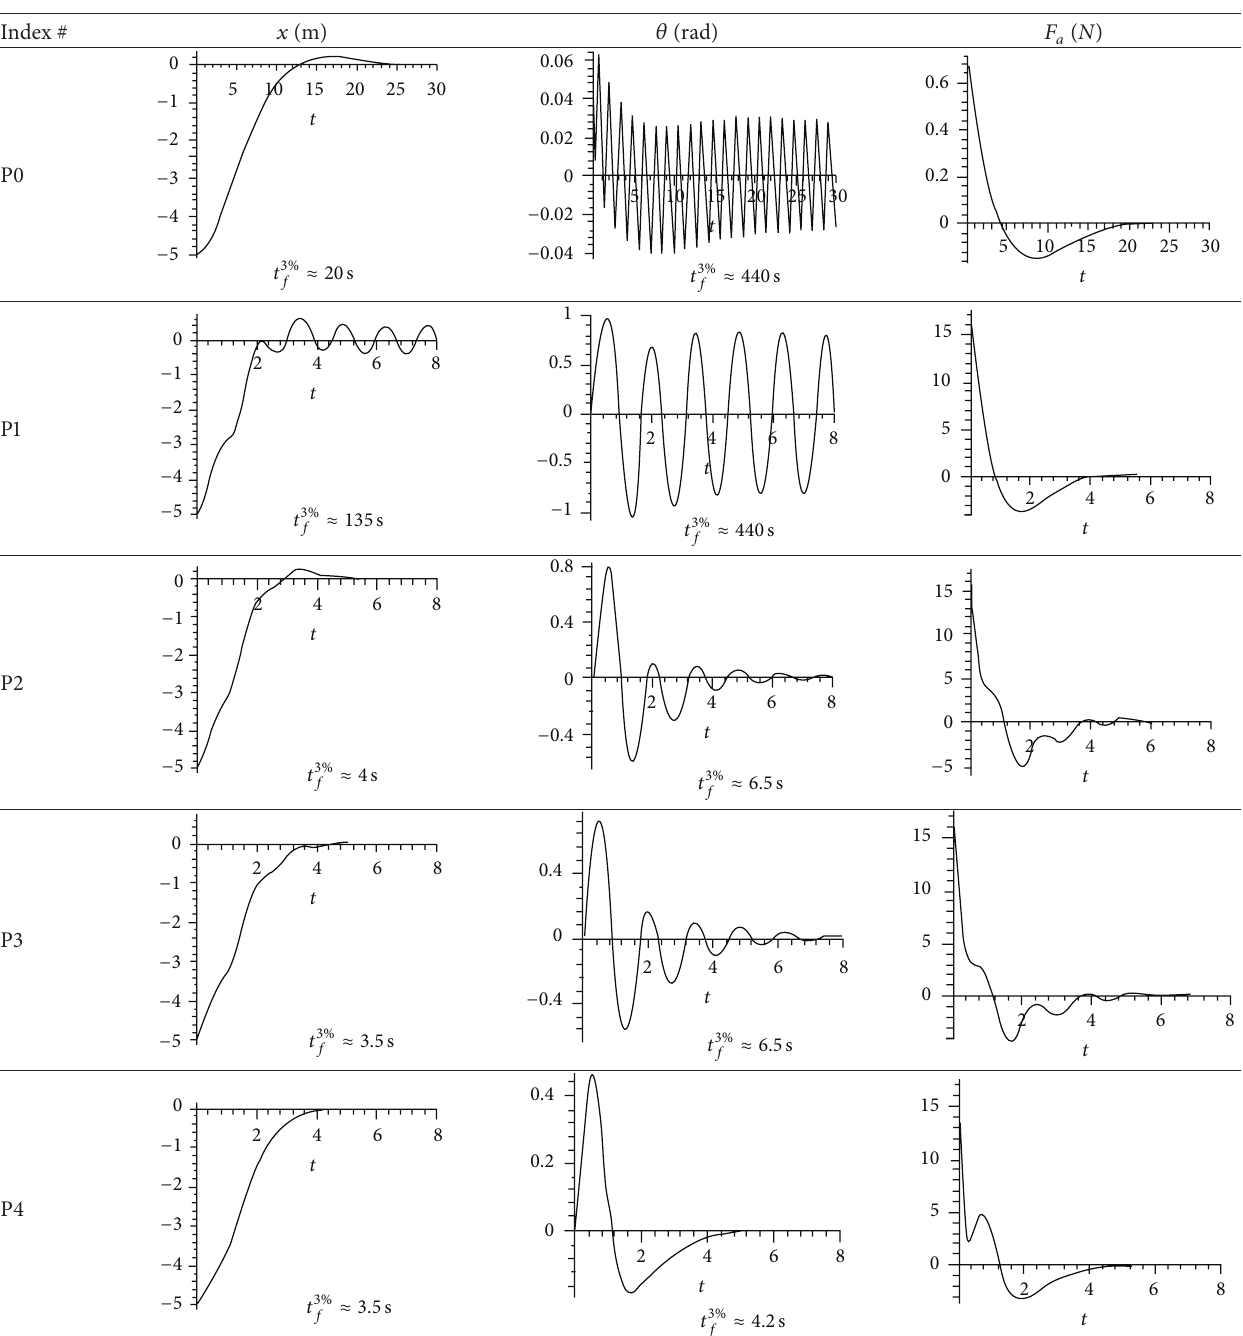
Table 2: DOF responses and force histograms that optimize performance indices